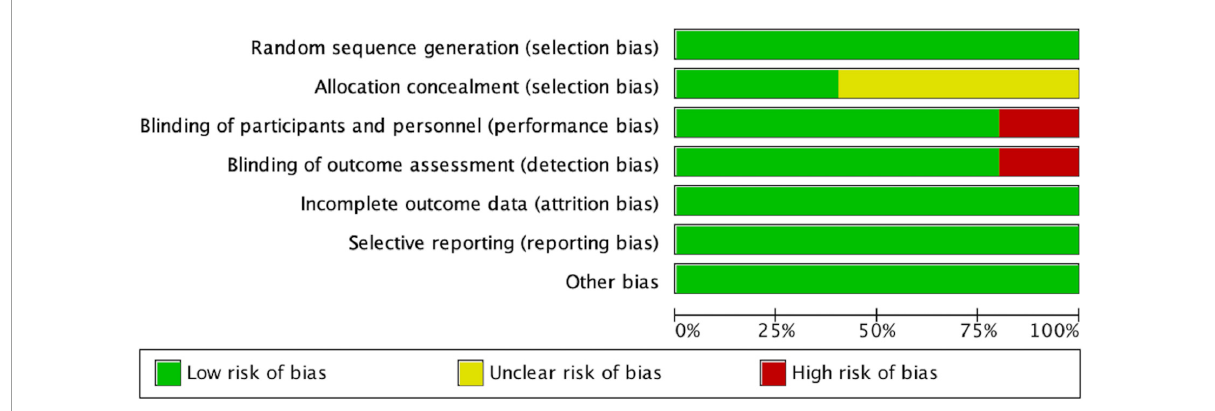
FIGURE4 Risk of bias graph, with risk of each type of bias presented as a percentage among included